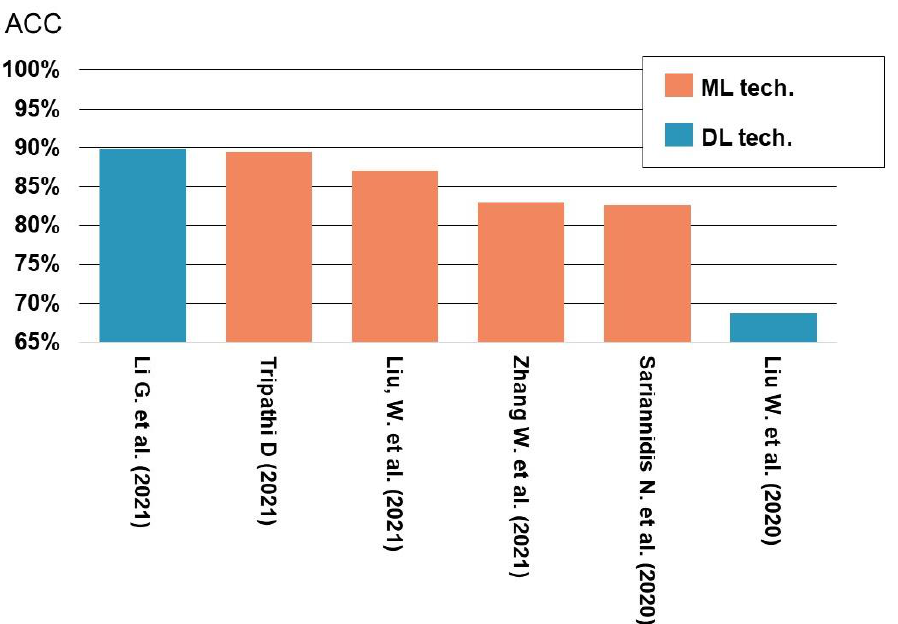
Figure 16. Comparison of accuracy of various classifiers for the Taiwanese dataset [47,50,58,61,63]. 6.4. Classifier Design Using Convolutional Neural Networks (CNNs) for Credit Scoring